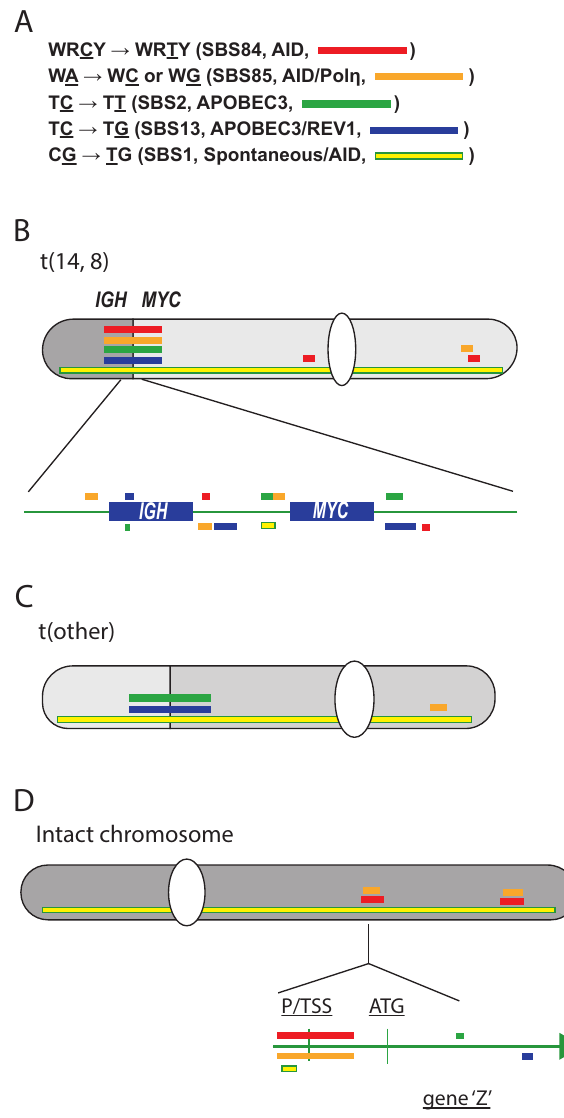
Figure 4. Localization of regions with specific mutational signatures in the multiple myeloma genomes. Mutational signatures identified in MM genomes are shown on panel ( A) . Panels ( B – D ) schematically show locations of these signatures on the chromosomes. There is substantial variability in the types of translocations and the strength of each individual mutational signature in the individual patient genomes and within tumor subclones. Thus, the scheme represents “averaged” features of the mutational signatures. Deamination in CpG motifs (yellow boxes